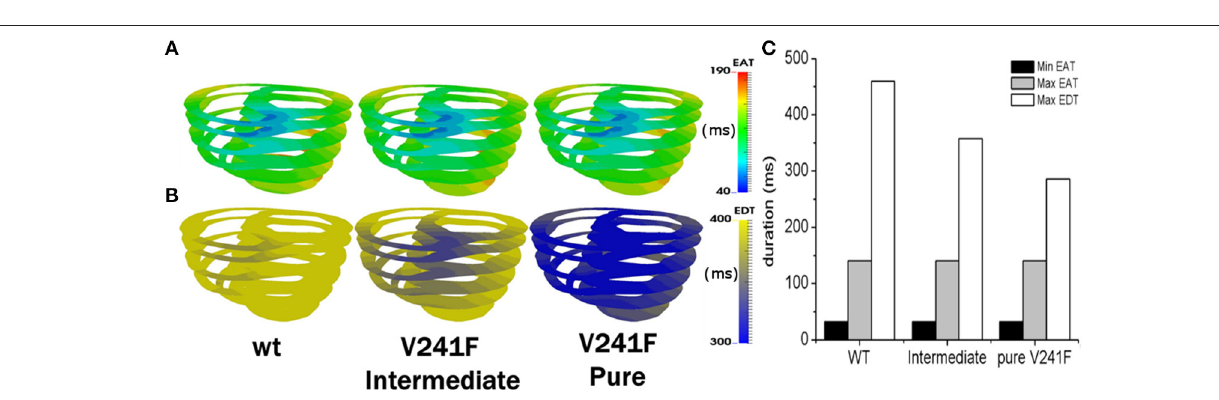
FIGURE 4 | EAT during one cycle of sinus pacing for WT, V241F intermediate and Pure Condition. (A) EAT mapped on ventricle model, (B) EDT mapped on ventricle model. (C) Comparison graph of minimum EAT, maximum EAT, and maximum